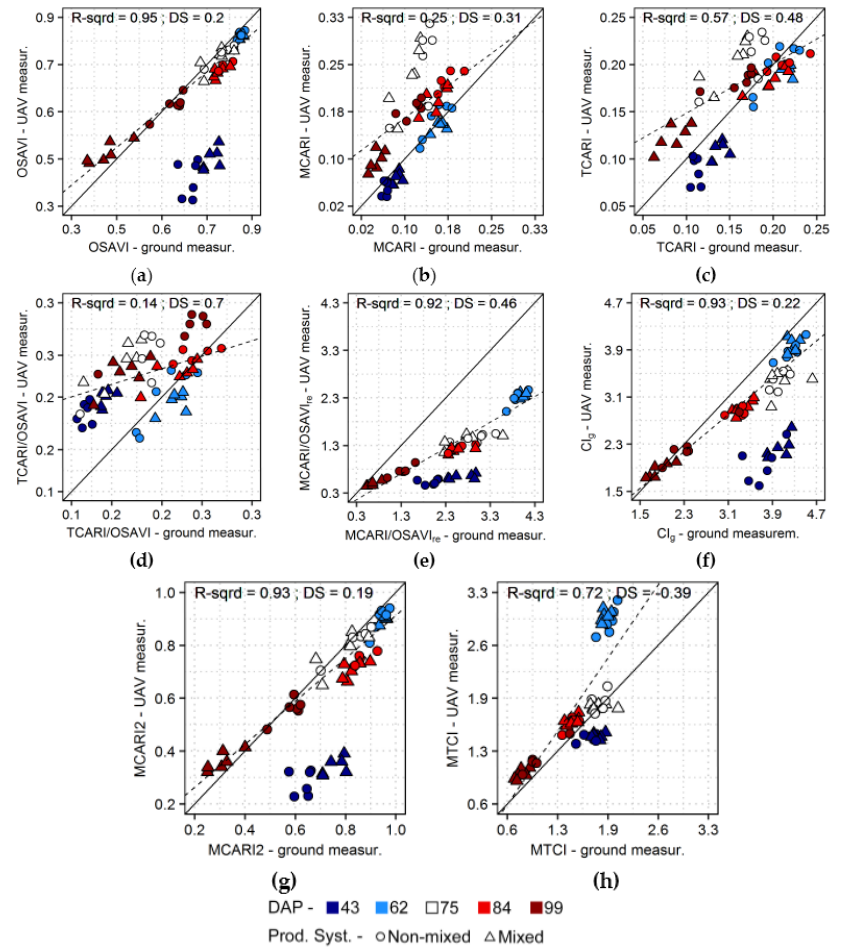
Figure 11. Intercomparison of spectra acquired with handheld and UAV-based spectrometers, for the vegetation indices with the best performace: ( a ) OSAVI, ( b ) MCARI, ( c ) TCARI, ( d ) TCARI/OSAVI, ( e ) MCARI/OSAVI re , ( f ) CI g , ( g ) MCARI2 and (h ) MTCI. R 2 and DS parameters, as well regression lines, corresponding to linear models fitted only to the last 4 acquisitions (from 62 to 99 DAP). DS indicates proximity of the linear relation between sensors to the 1:1 line, with zero meaning that this relation corresponds exactly to the 1:1 line.